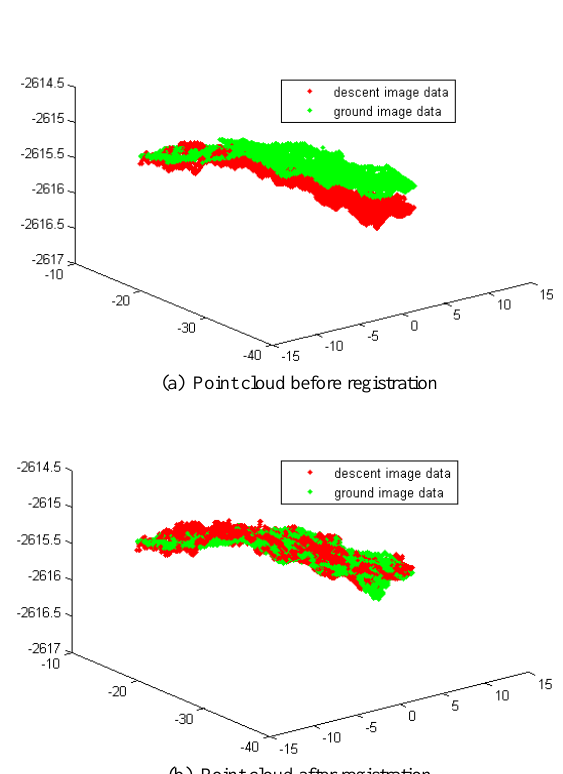
Figure 3. Co-registration of two datasets